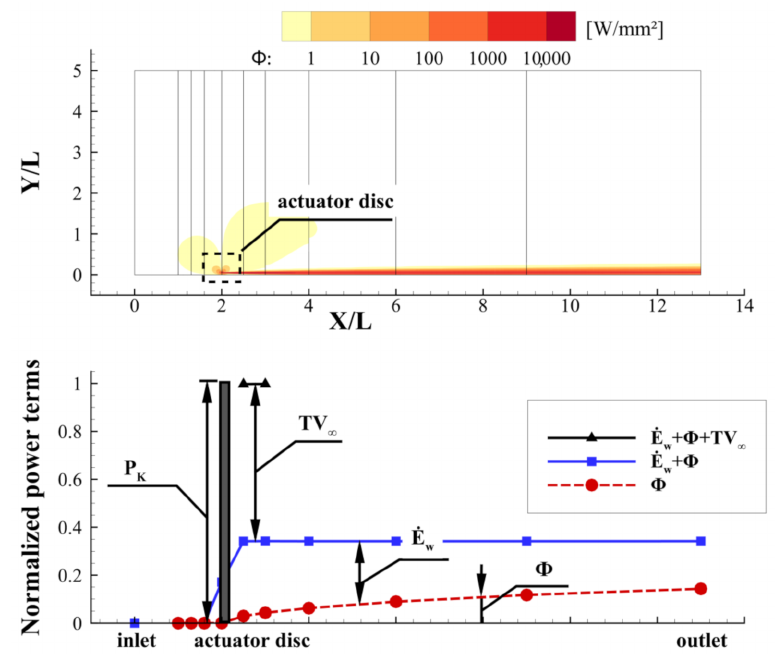
Figure 8. Contours of the integrand of viscous dissipation ( top ) and the power bookkeeping of the actuator disc ( bottom ) [19].